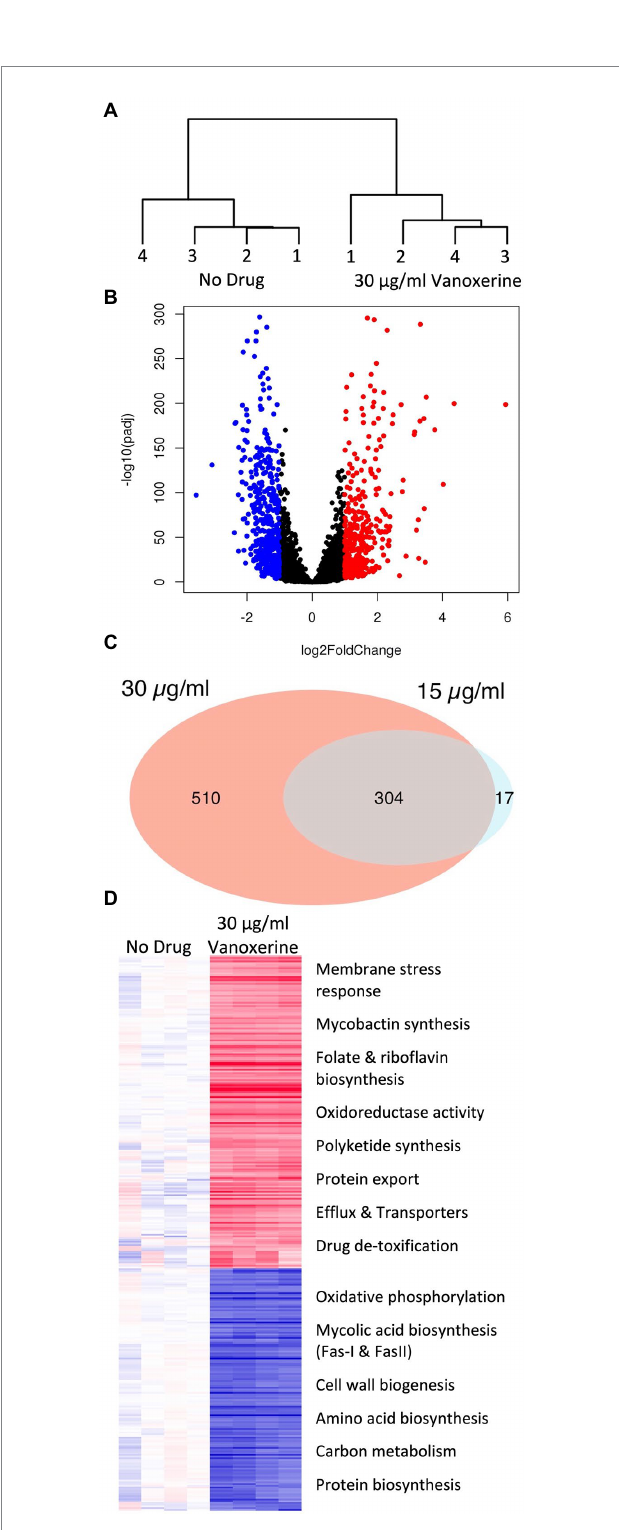
FIGURE 5 Transcriptomic changes following drug treatment of M. bovis BCG relative to a DMSO-only control. RNA sequencing was performed on four independent samples from each condition. (A) A dendrogram, highlighting the samples differences present, due to transcriptional variation between the DMSO-only samples and 30 μ g/ml vanoxerine- treated samples, following 8-h of drug treatment. (B) Volcano plot indicating the significantly dysregulated genes. Highlighted points have a fold change >2 and a p -adjusted value of <0.05; red = upregulated, blue = downregulated. (C) Venn diagram comparing the significantly dysregulated genes following 15 vs. 30 μ g/ml vanoxerine treatment. (D) Clustered comparison of transcriptional differences between DMSO-only and 30 μ g/ml vanoxerine. Biological functions of the dysregulated genes are